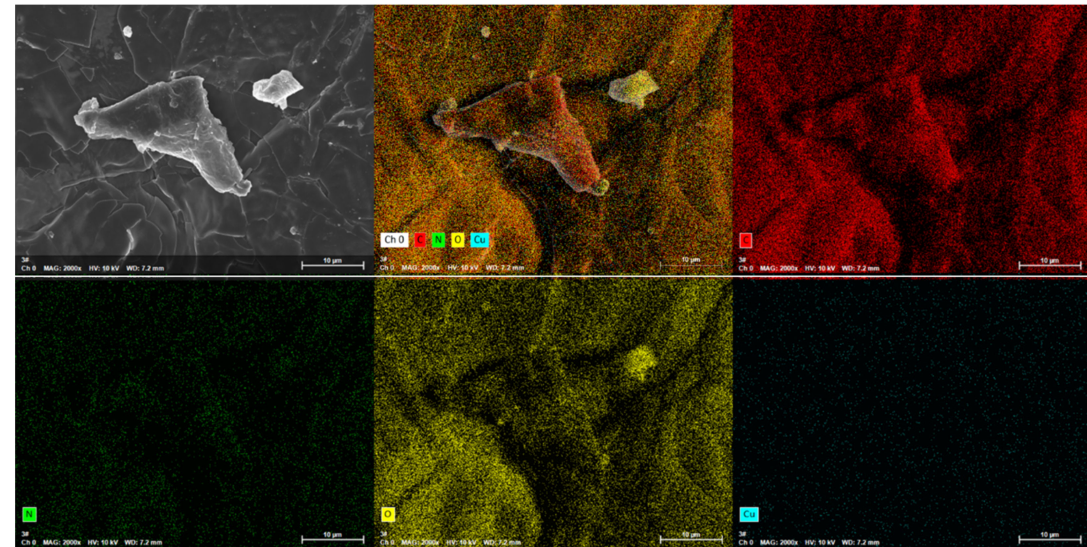
Figure 5. SEM corresponding elemental mapping images of Cu II/I @CMC-PANI film.